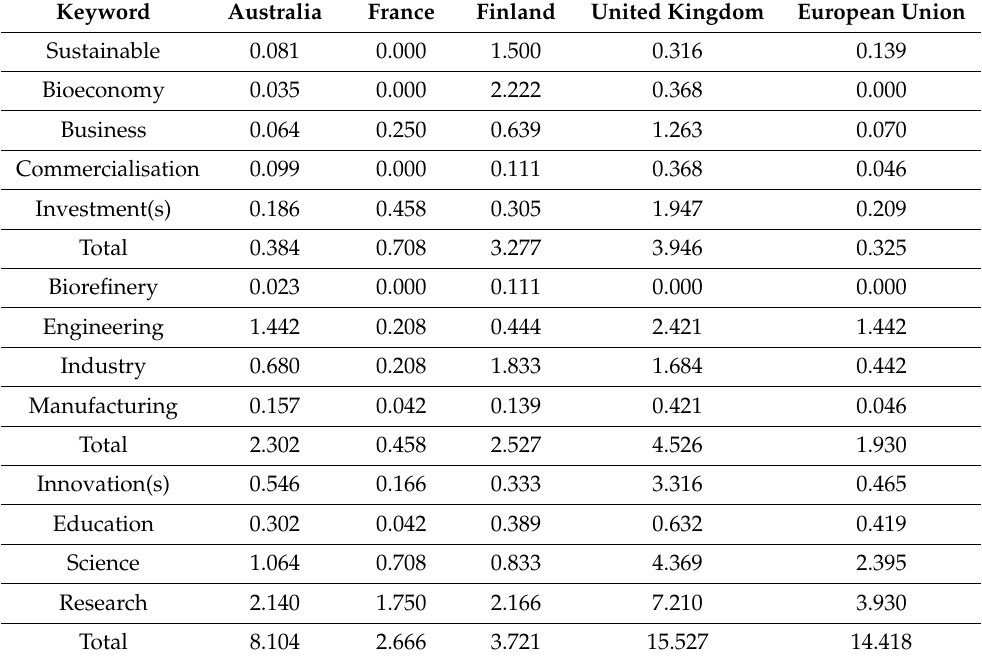
Table 1. Word analysis of synthetic biology roadmaps. The words are loosely grouped into three groups, the first being bioeconomy and commerce-based, the second being engineering and industry- based, and the third being science and research-based. The numbers represent the number of times each keyword appears per